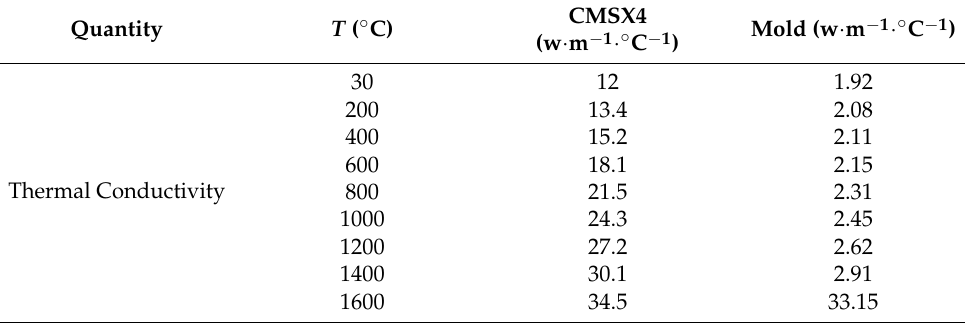
Table 3. Thermophysical properties of the superalloy and mold materials used for